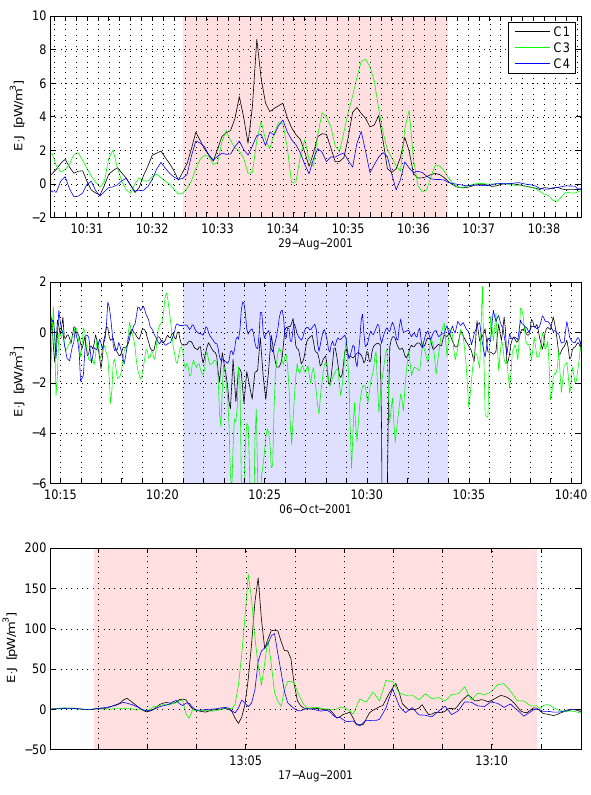
Fig. 3. Three examples of ECRs observed by Cluster from the 2001 plasma sheet data. (For examples of the electric field and current density signatures within ECRs, we refer to Fig. 2 in H09A.) Top panel: Typical example of a CLR where all three spacecraft are embedded inside the CLR and see approximately the same power density signatures. Middle panel: Typical example of a CGR. In this case C4 is outside the CGR and C1 is rather close to the edge. Bottom panel: The only event with a clear time shift observed in the data base. The CLRs (CGRs) are highlighted in red (blue). Note the different scalings of the power density and time axes. Especially the CLR in the bottom panel show large power densities around 13:05, making the nearby fluctuations seem insignificant even though they are well above the 0.4pW/m 3 threshold of the automatic selection